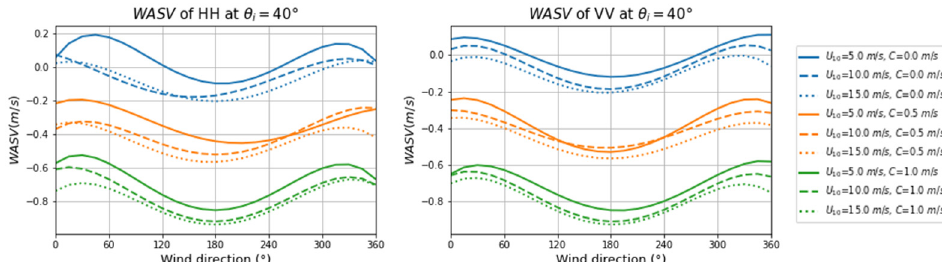
Figure 8. The relationship between WASV and wind direction at an incidence angle of 40° for HH and VV polarizations. The swell direction, amplitude, and wavelength were 0°, 0.5 m, and 200 m, respectively. Other input parameters were set to the values indicated in Table 1.